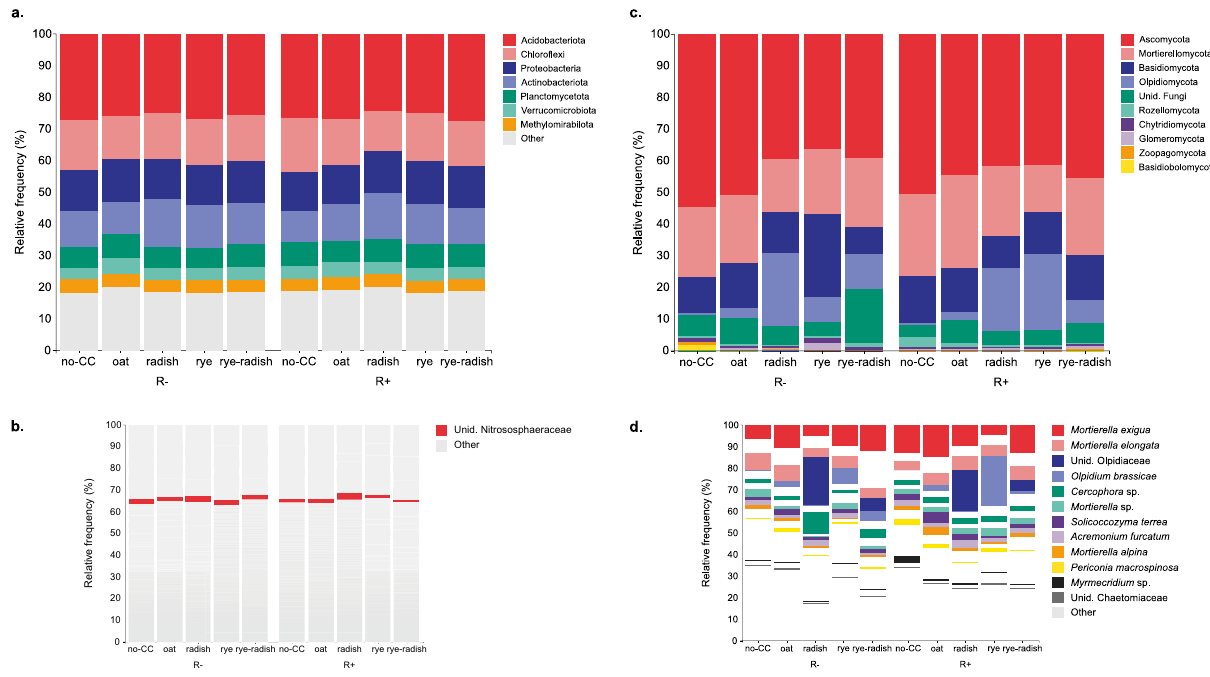
Figure 3. Changes in the relative frequency (%) of soil microbial taxa in different CCs and residue management treatments: ( a , c ) Prokaryotic and fungal phyla, respectively; ( b , d ) Prokaryotic and fungal species (or highest classification available) with visually evident changes in frequency, respectively. Each treatment is represented by pooled reads from four field replicates. In ( a ), all phyla in the legend are bacterial and lower abundance phyla were pooled as “Other”. In ( b , d ), taxa with no visually clear changes in frequency were pooled as “Other”. R−/ R+ refers to main crop residues absent or present,